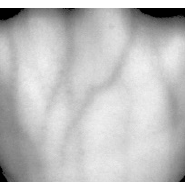
Figure 4. Gray ‐ normalized ROI dorsal hand vein image.